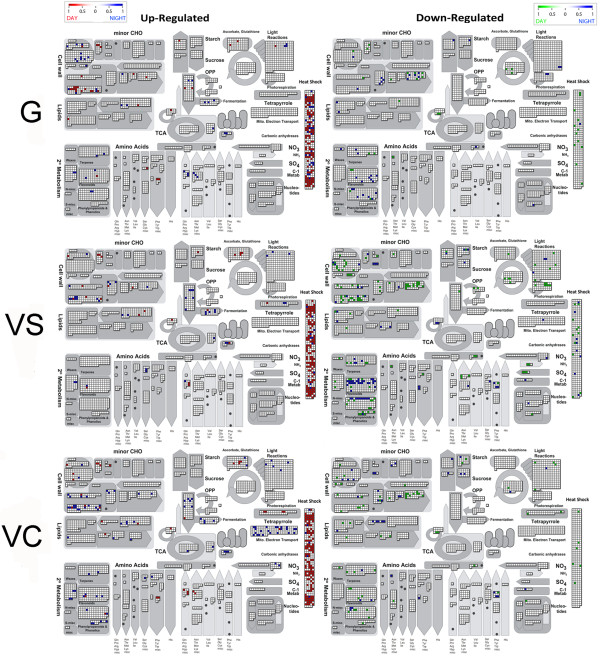
MapMan overview of day and night modulated transcripts at the three different stages: G (Green), VS (VéraisonSugar) and (VC) (VéraisonColor). Left: up-regulated transcripts; Red: day and night modulated; Blue: night-specific; Right: down-regulated transcripts; Green: day and night modulated, Blue: night-specific. Scale in log2 control/stress.